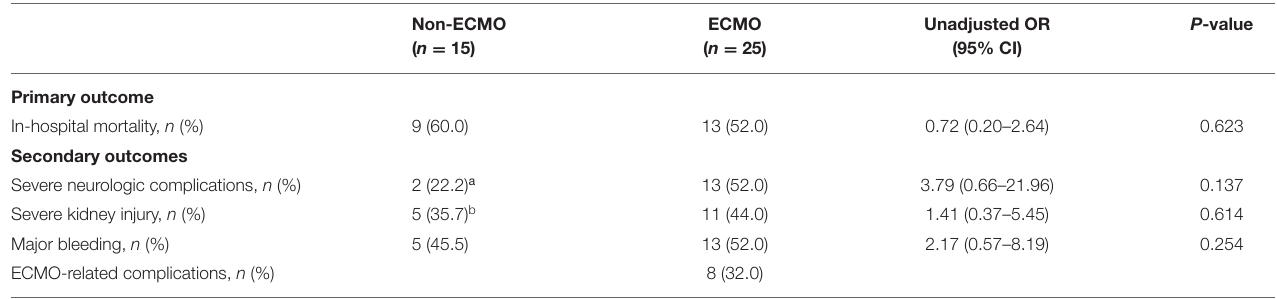
TABLE 3 | The primary and secondary